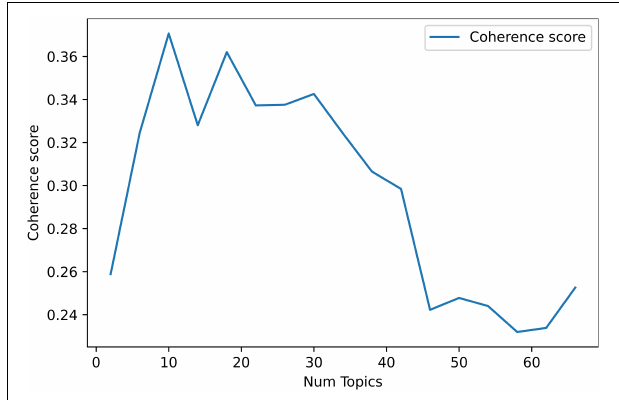
FIGURE 5 | Coherence score for optimum number of topics in the topic modeling (retweets